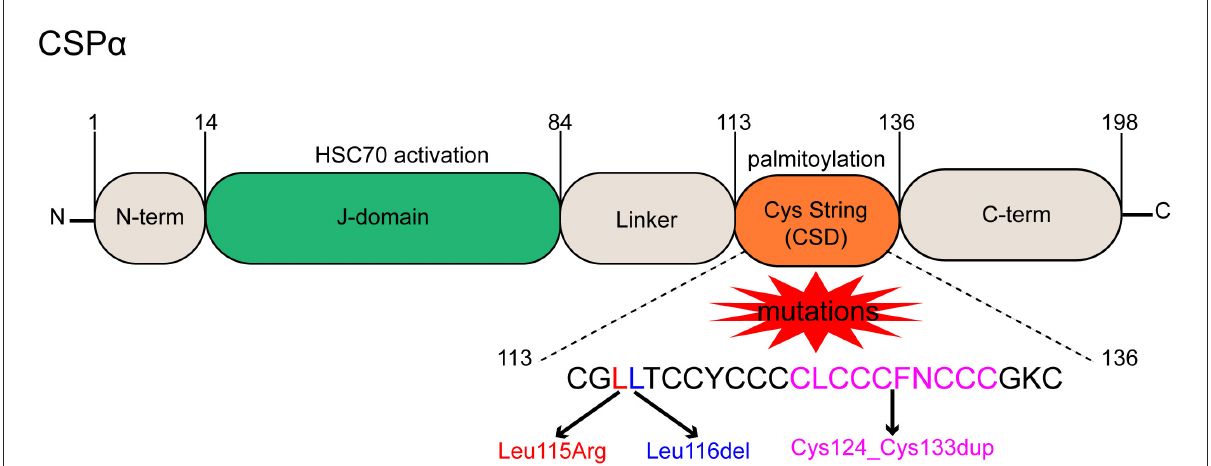
FIGURE1 Functional domains and mutant forms of CSP α . CSP α consists of 5 domains, a small N-term domain, a J-domain is essential for HSC70 interaction and activation, a hydrophobic linker, a cysteine string domain (CSD) containing cysteine residues for palmitoylation, and a disordered C-term domain. Three mutations result in ANCL, a single base change replaces Leu115 with an arginine residue (p.L115R), a loss of Leu116 caused by deletion of three nucleotides (p.L116 δ ), and a 30-bp intra-frame duplication (Cys124_Cys133dup) of the central core motif in the CSD.